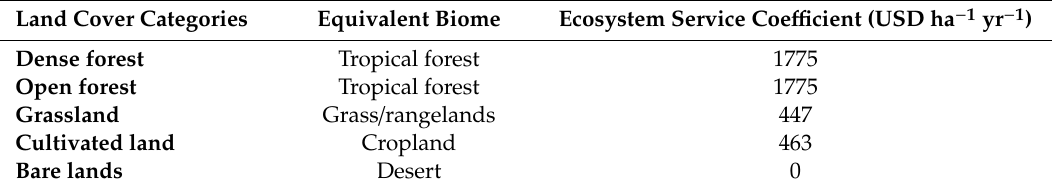
Table 3. Land cover types and biome equivalents with the corresponding value coe ffi